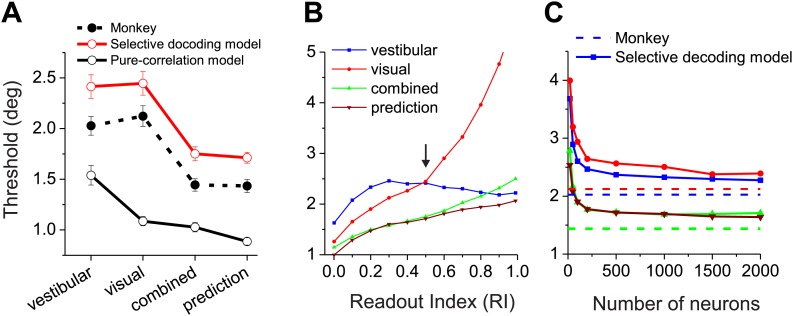
Comparisons between model population threshold and psychophysical performance of the animals.(A) Average thresholds are shown for the vestibular, visual, and combined conditions, along with the prediction from optimal cue integration theory. Data are shown for the average of two monkeys (filled symbols, dashed curve), for predictions of the pure-correlation model (black open symbols and solid curve), and for predictions of the selective decoding model with RI = 0.5 (red symbols and curve). (B) Predicted thresholds from the selective decoding model are plotted as a function of Readout Index for vestibular, visual, and combined conditions, as well as the optimal prediction from the single-cue thresholds. (C) Thresholds from the selective-decoding model (with RI = 0.5) as a function of population size. Solid curves: model predictions; dashed horizontal lines: average performance of two animals.